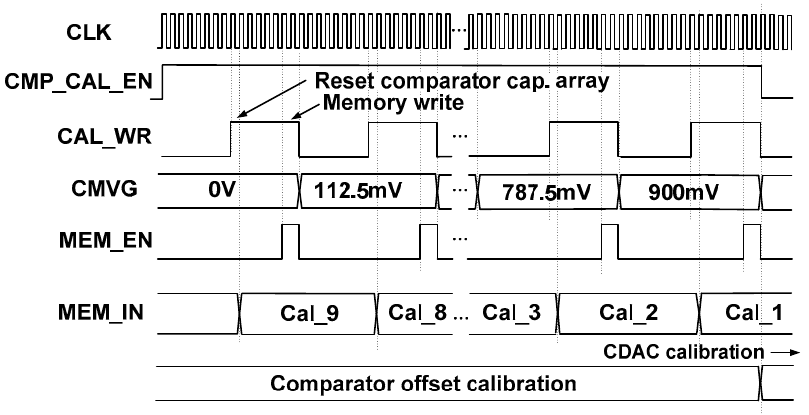
Figure 7. Timing waveform for comparator offset measurement.